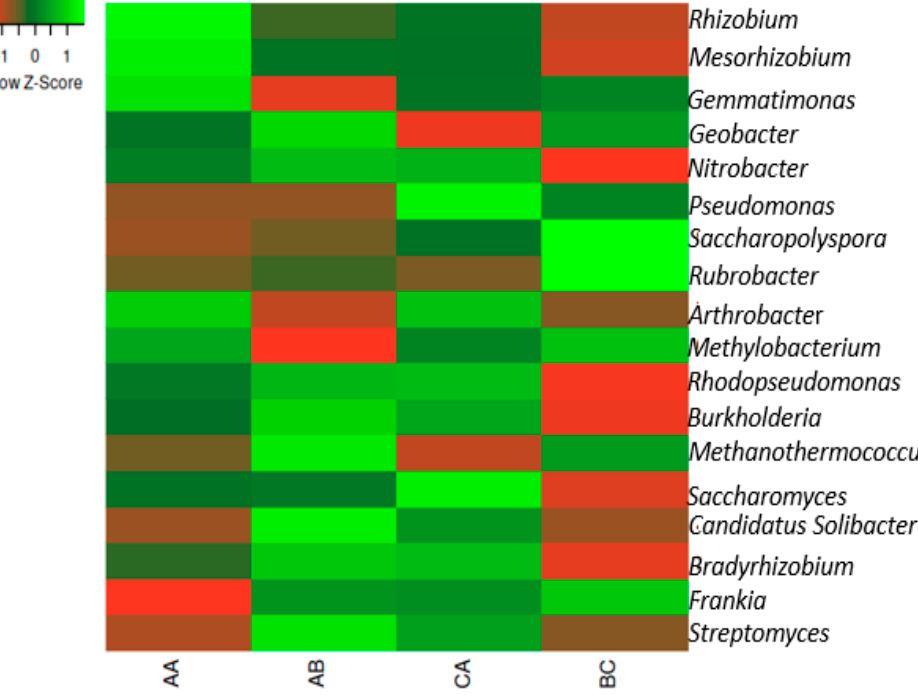
Figure 2. The heatmap representation of the relative abundances of the genera in the samples. The scale bar depicts a color saturation gradient based on relative abundances of the genera that have been z-score converted. AA, AB, and CA are rhizosphere soil samples while BC is bulk soil sample.